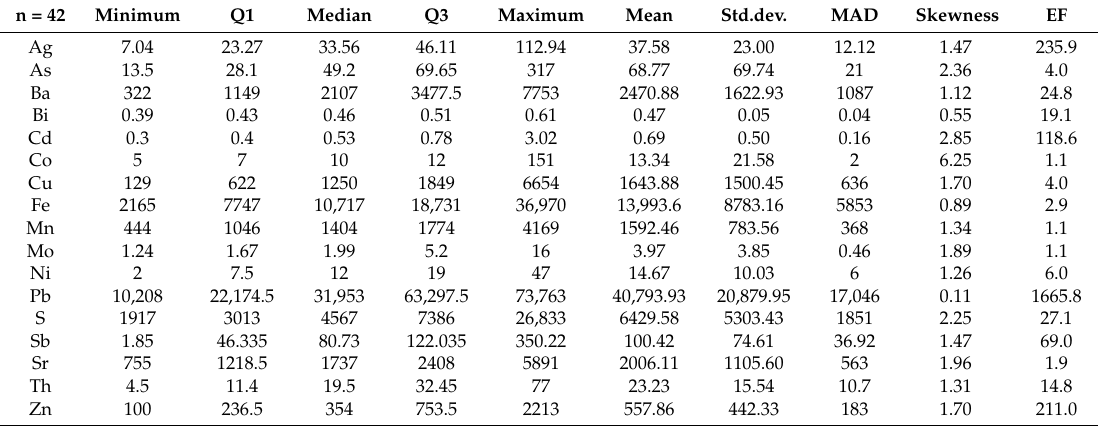
Table 3. Statistical parameters for tunnel samples from 2391 m and 2353 levels (n = 42) from Block A of the Ravanj deposit (in ppm). n, number of samples; Q1, 1st quartile; Q3, 3rd quartile; MAD, median of absolute deviation from data median; EF, enrichment